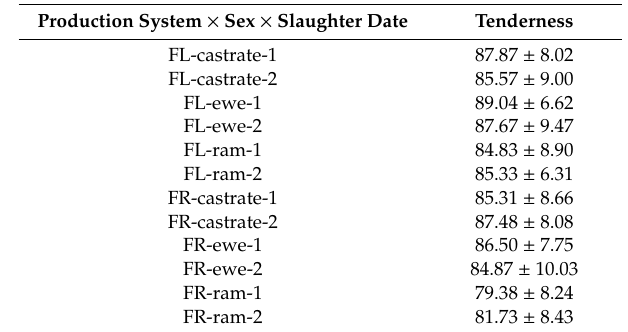
Table 4. Means ( ± s.d.) depicting the e ff ect of the three-way interactions (production system × sex × slaughter date) on the tenderness scores of Dorper